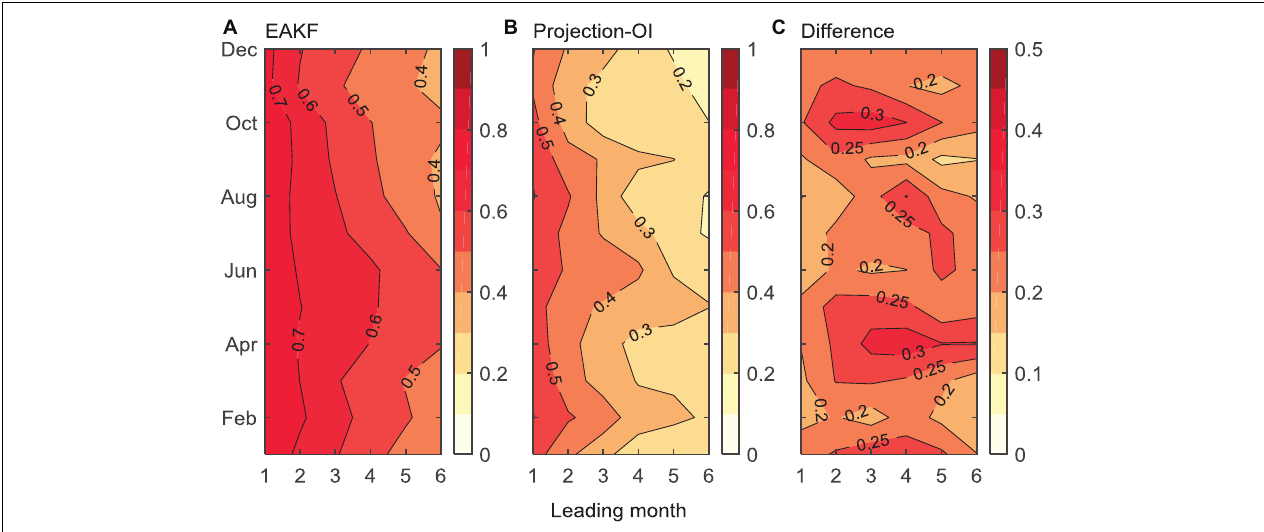
FIGURE 7 | Evolution of area-averaged ACC over the North Pacific (20–70 ◦ N, 110 ◦ E–100 ◦ W); the horizontal axis represents the length of hindcasts, and the vertical axis indicates the starting month. (A) EAKF; (B) Projection-OI; and (C) EAKF–Projection-OI.